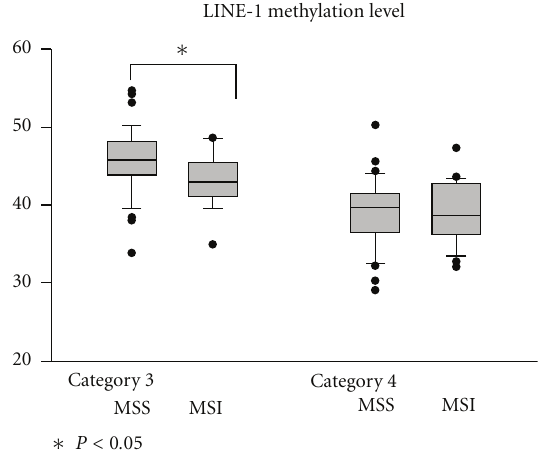
Figure 4: Level of LINE-1 hypomethylation in gastric epithelial neoplasias categorized by the revised Vienna classification. There were no significant di ff erences of LINE-1 methylation level accord- ing to the degree of LOH and MSI state. Except in category 3, the lesions with MSI had the lower LINE-1 methylation level than that of MSS. Box plots illustrate median values, 25th and 75th percentiles, and outliers on a linear scale. The unpaired t test and one way ANOVA were applied for nonparametric statistical analysis, and ∗ was considered statistically significant ( P < 0 .